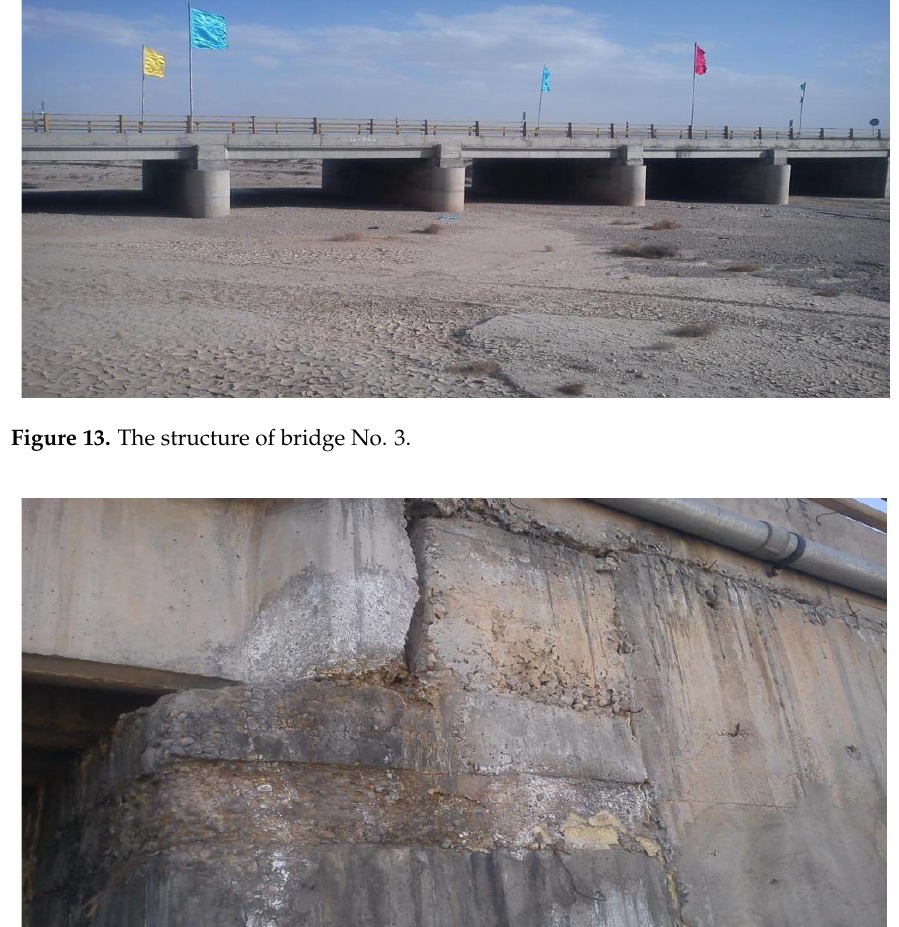
Figure 14. An example of structural damage in bridge No. 3.